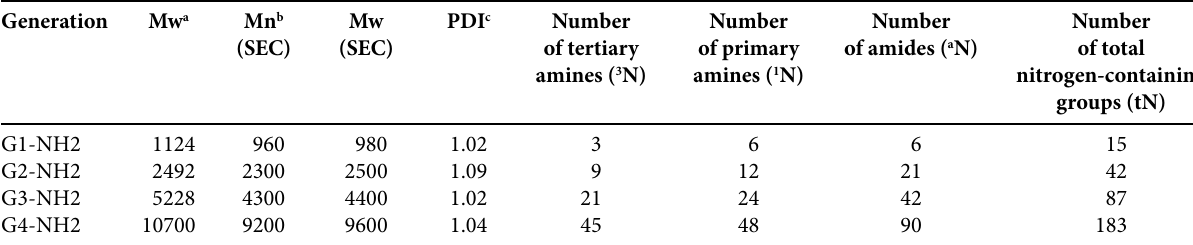
Table 1. Selected physico-chemical properties of JCPDs. 31